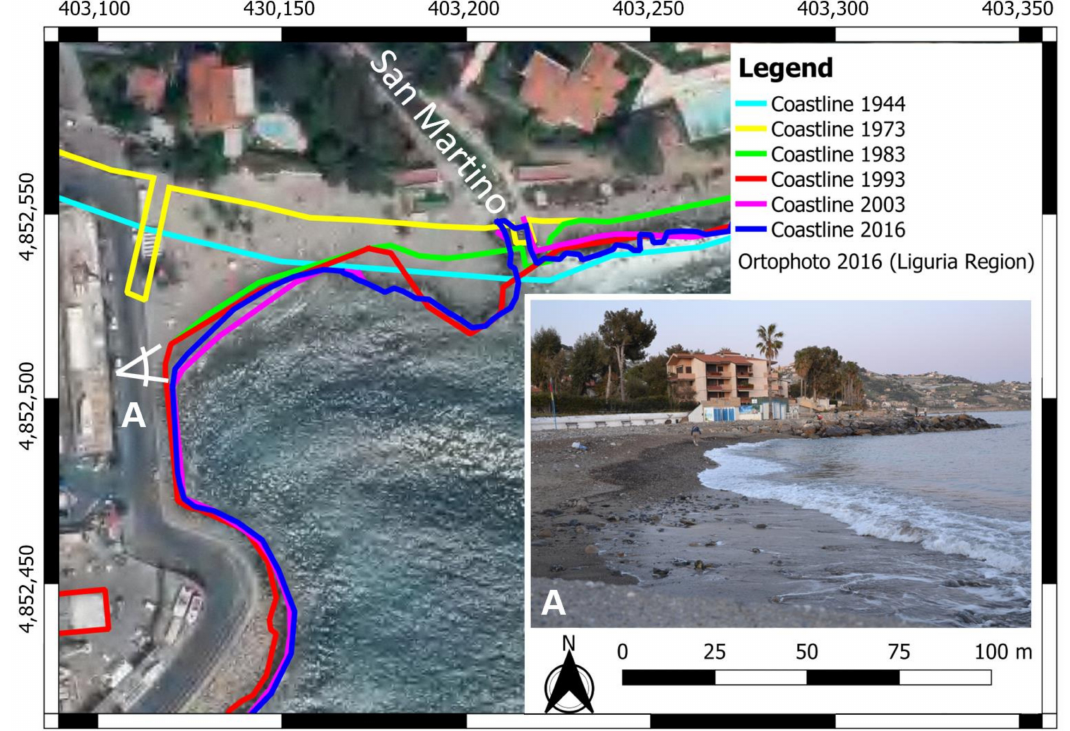
Figure 3. Variations of the position of the shoreline over the years 1944–2016 [58], Liguria Region orthophoto of 2016 used as background. ( A ) Photo taken from the west (the point of view is indicated in white on the main map) shows the features of the shoreline deposits. The coordinates are expressed in the ETRF2000–2008.0 reference system with UTM 32